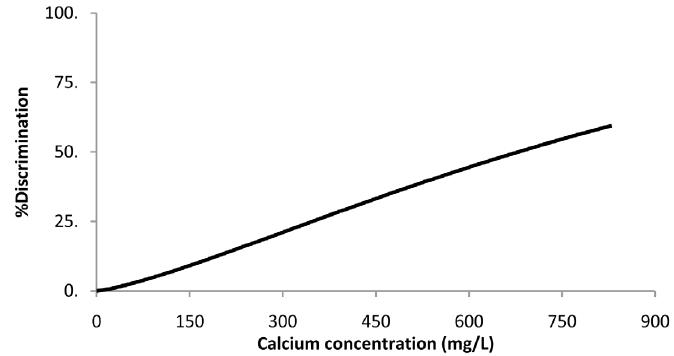
Figure 2. Calcium lactate pentahydrate threshold taste. Percent discrimination versus calcium concentration for the Weibull